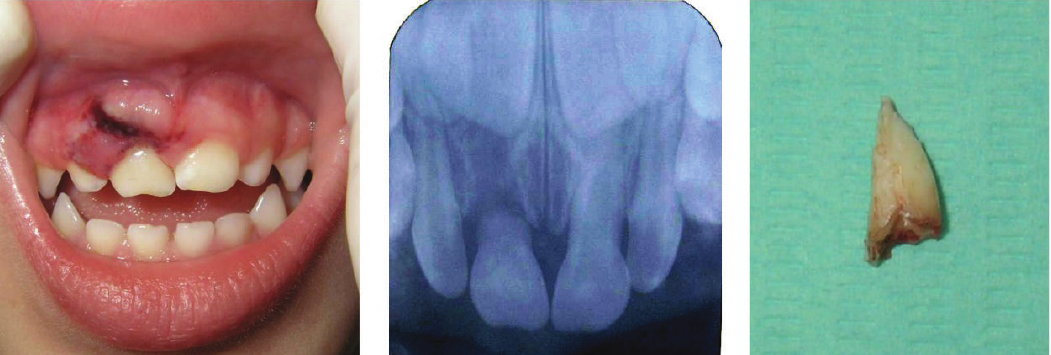
Figure 1: Intraoral view two hours after trauma. Periapical radiography. Root of the primary maxillary right central incisor root.